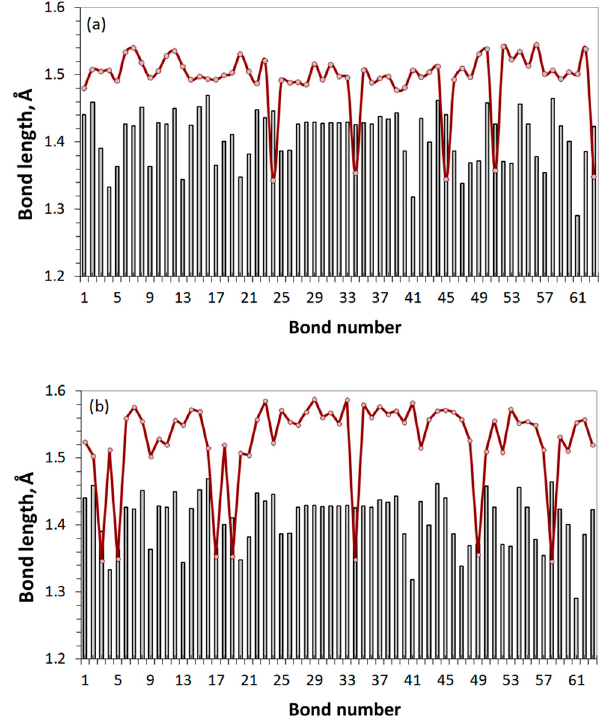
Figure 10. The sp 2 - to -sp 3 transformation of the C-C covalent bonds of the (5,5) NGr domain in consequence of the successive hetero-oxidant action. The final-stage oxidation of ( a ) GO1 and ( b ) GO3 (see text for details). Gray histogram is related to the pristine domain.